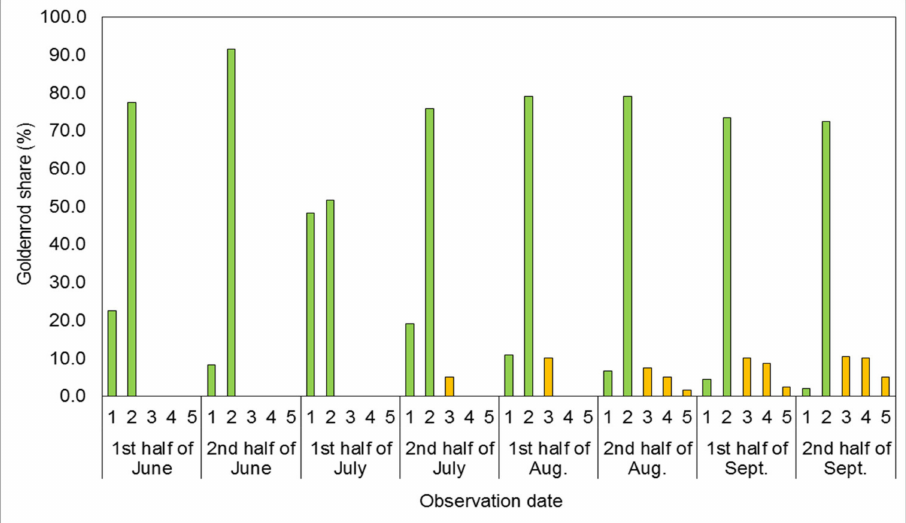
Figure 3. Mean share of goldenrods in successive developmental stages covering the plots’ surfaces in the two-time mowing treatment (2M). In Figures 1–5, vegetative stages are marked green, while generative stages are orange, and the numbers mark the successive stages of the goldenrods’ develop- ment: (1) emergence and early vegetation, (2) development of shoots, (3) formation of inflorescences, (4) flowering, and (5) fruiting and shedding of